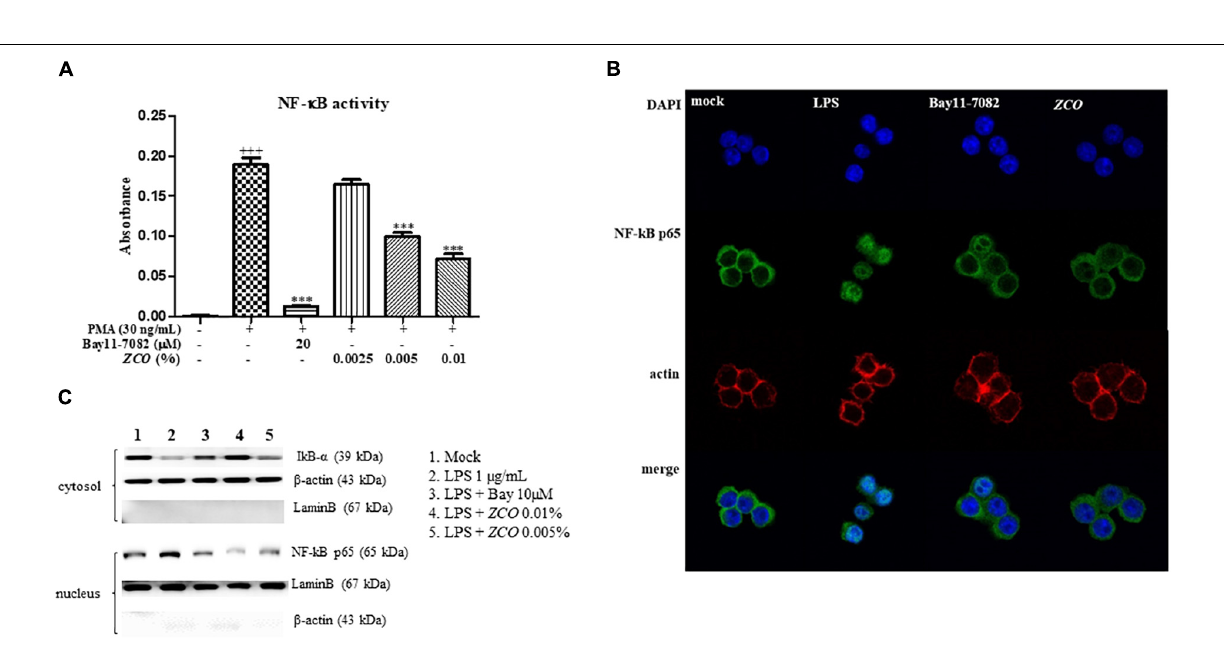
Frontiers in Pharmacology |